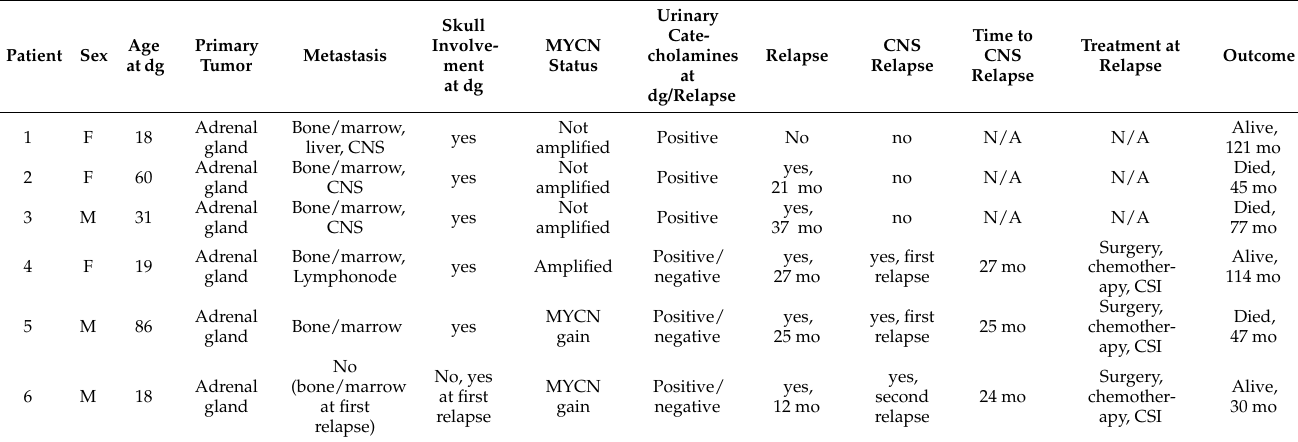
Table 1 summarizes the clinical characteristics of patients with CNS metastatic spread. Table 1. Patient